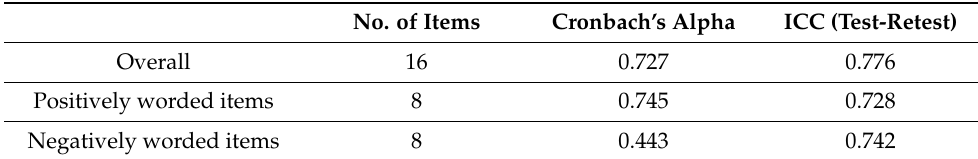
Table 1. Internal and external reliability ( n = 67).